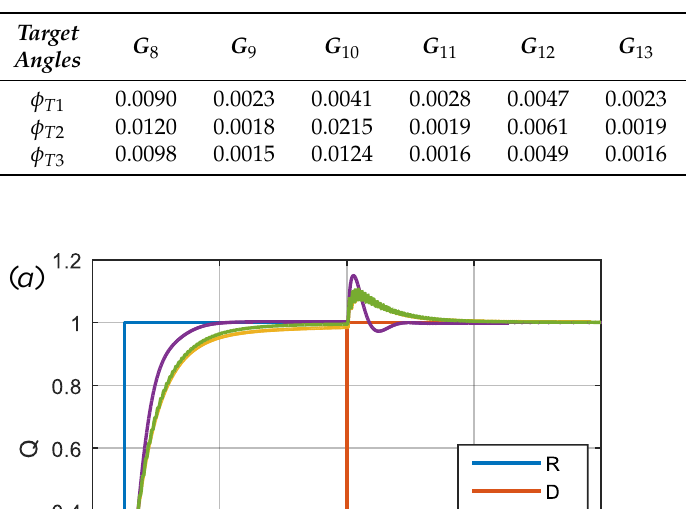
Table 5. MSE values of step responses for the other 8 plant functions ( G 8 to G 16 ).